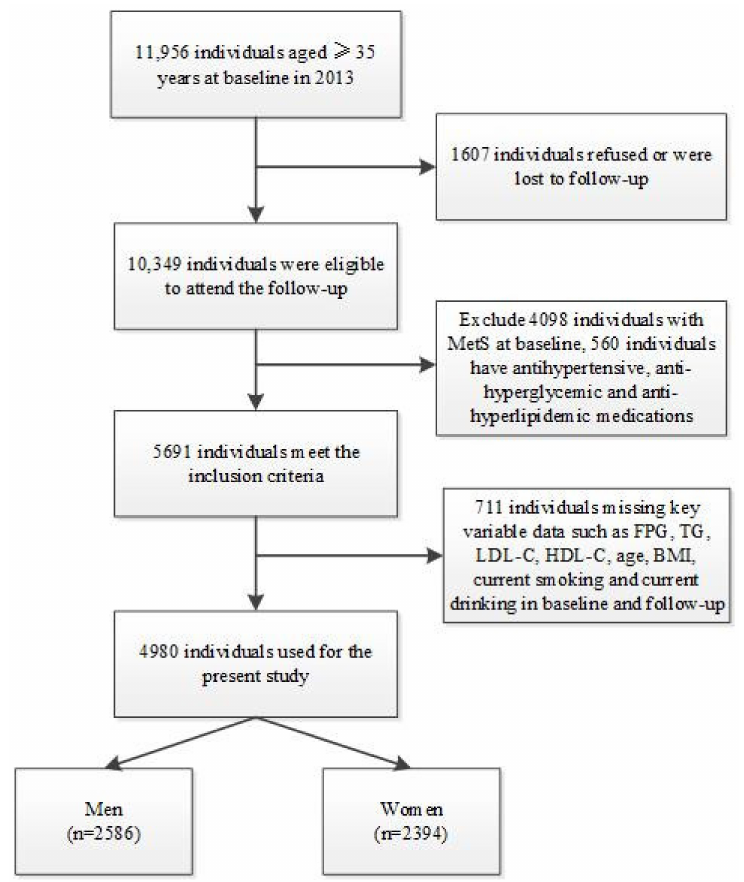
Figure 1. Flow chart of the participants included in this study after inclusion and